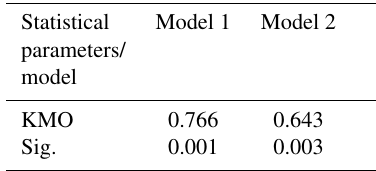
Table 6. Statistical parameters of the two